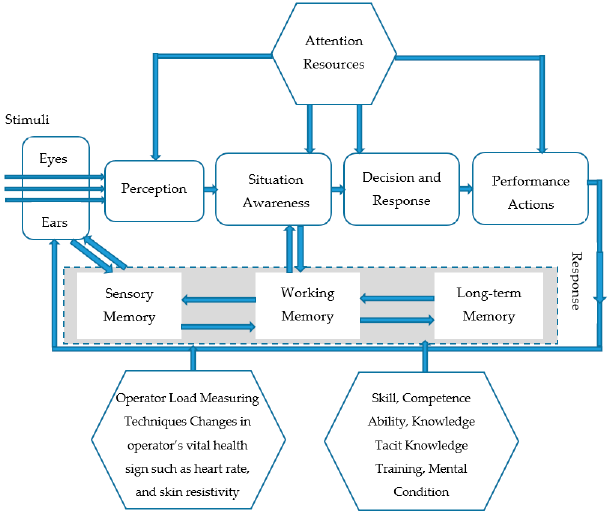
Figure 5. The improved model of “Human Information Processing and Decision-Making” published Figure by [46].